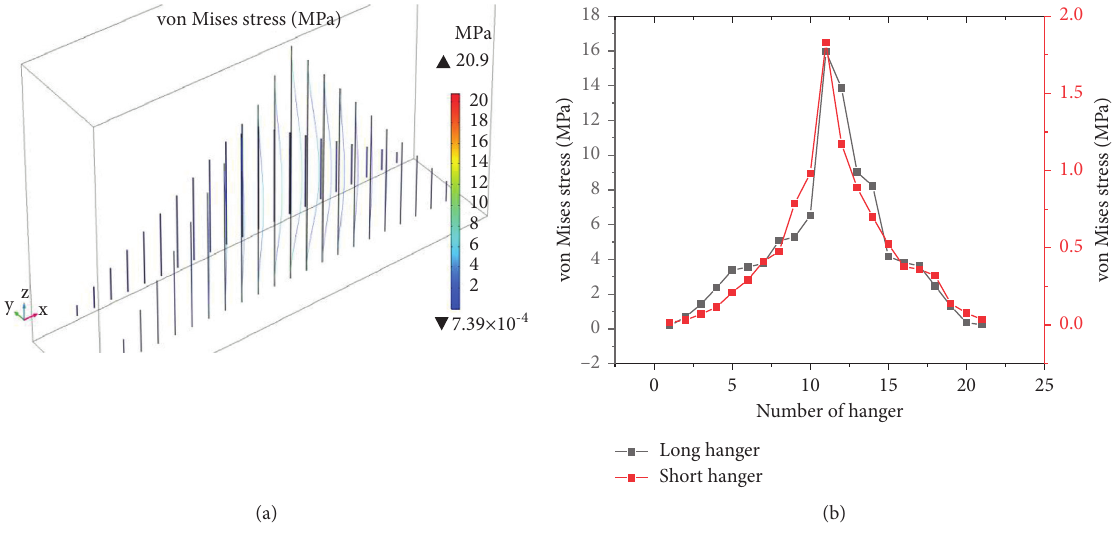
Figure 16: Stress distribution of hangers (wind direction � 270 ° ).